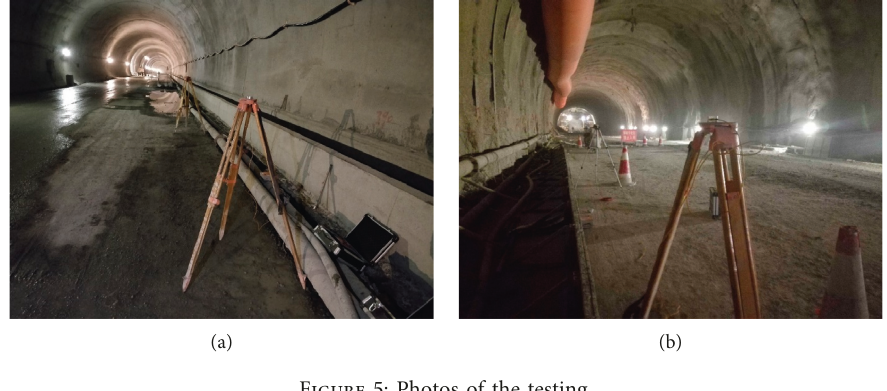
Figure 5: Photos of the testing.